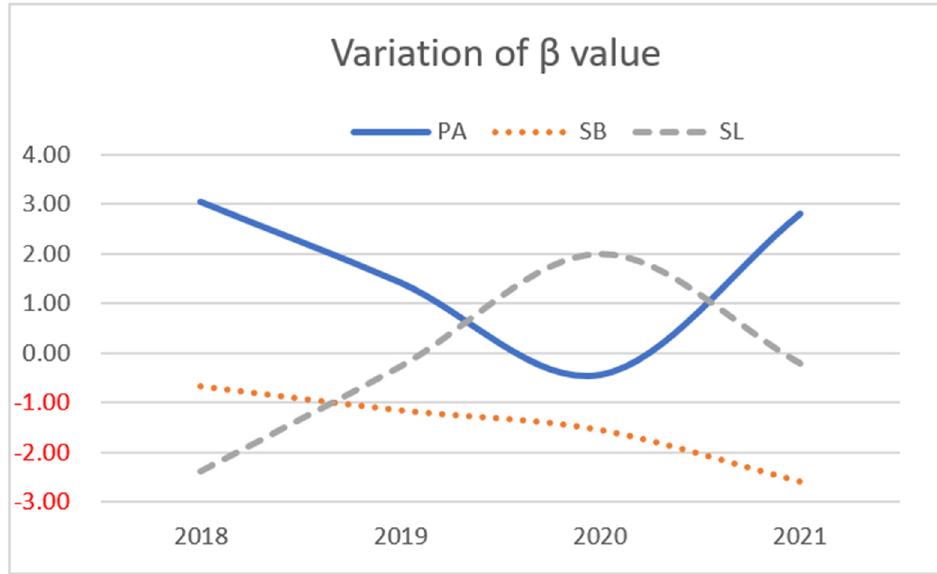
Figure 3. A line graph of the regression coefficients for PA, SB, and SL, respectively, plotted across four years. β values are regression coefficients and were chosen from the adjusted linear regression model, which represents a total effect of the predictor variables [44].The y -axis displays the β value, while the x -axis shows the different years from 2018–2021.The different lines represent different changes in β for PA, SL, and SB. PA = Physical activity; SL = Sleep; SB = Sedentary behaviour.